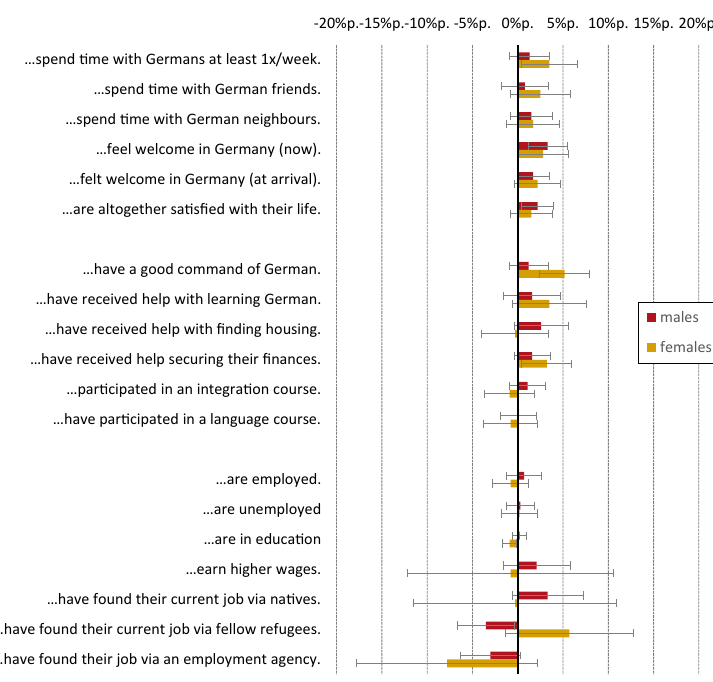
Figure 4: Relationship between local civic engagement and indicators for social integration by gender. Source: IAB-BAMF-SOEP Refugee Survey 2016 – 2019, own